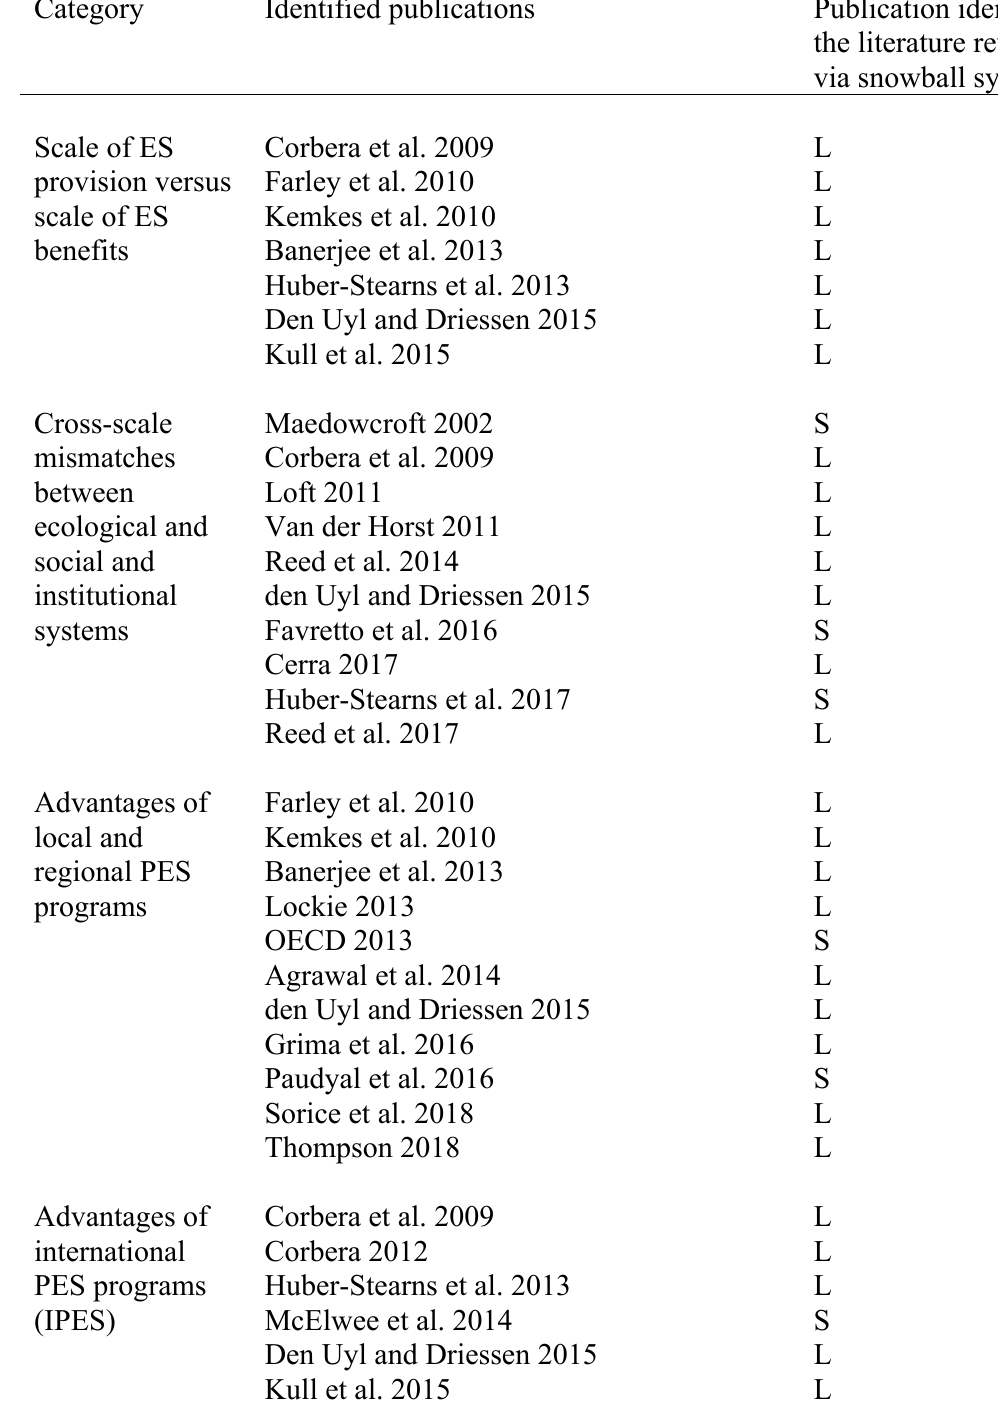
Table A2. Coding system for the systematic literature review addressing the influence of spatial scales on PES program effectiveness; cited literature is assigned to the main categories of the coding system and divided into publications directly identified in the literature review and further publications identified based on a snowball